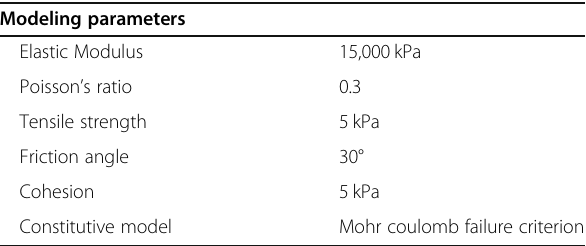
Table 1 Modeling parameters Modeling